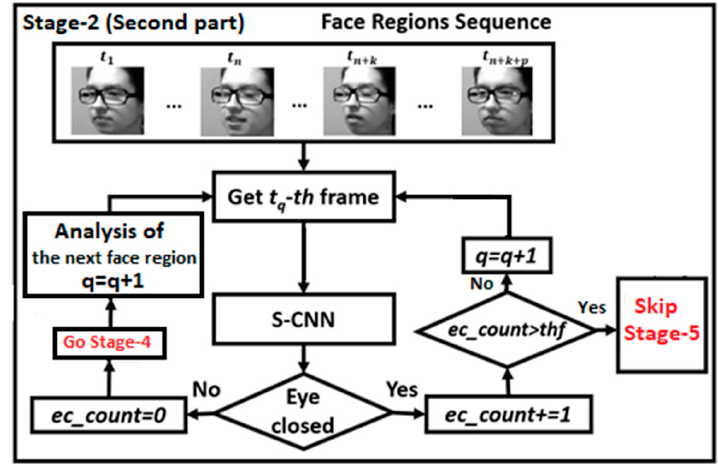
Figure 7. Proposed driver’s drowsiness detection algorithm.